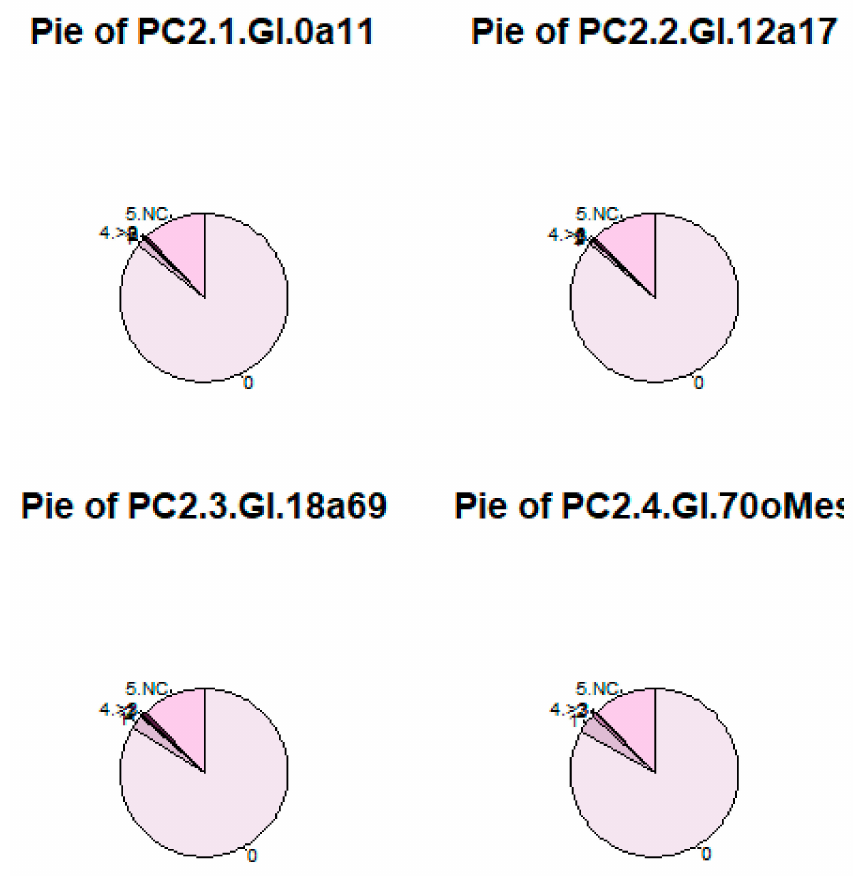
Figure 31. Grid of pie charts of question PC2.1-PC25.4. The variable shows modalities 0 (means 0 dependent persons in charge),1,2,3,4. > 3 (more than 3) and 5.NC (unknown). Since some modalities are so infrequent labels overlap. The exact figures are shown in Figures 29 and